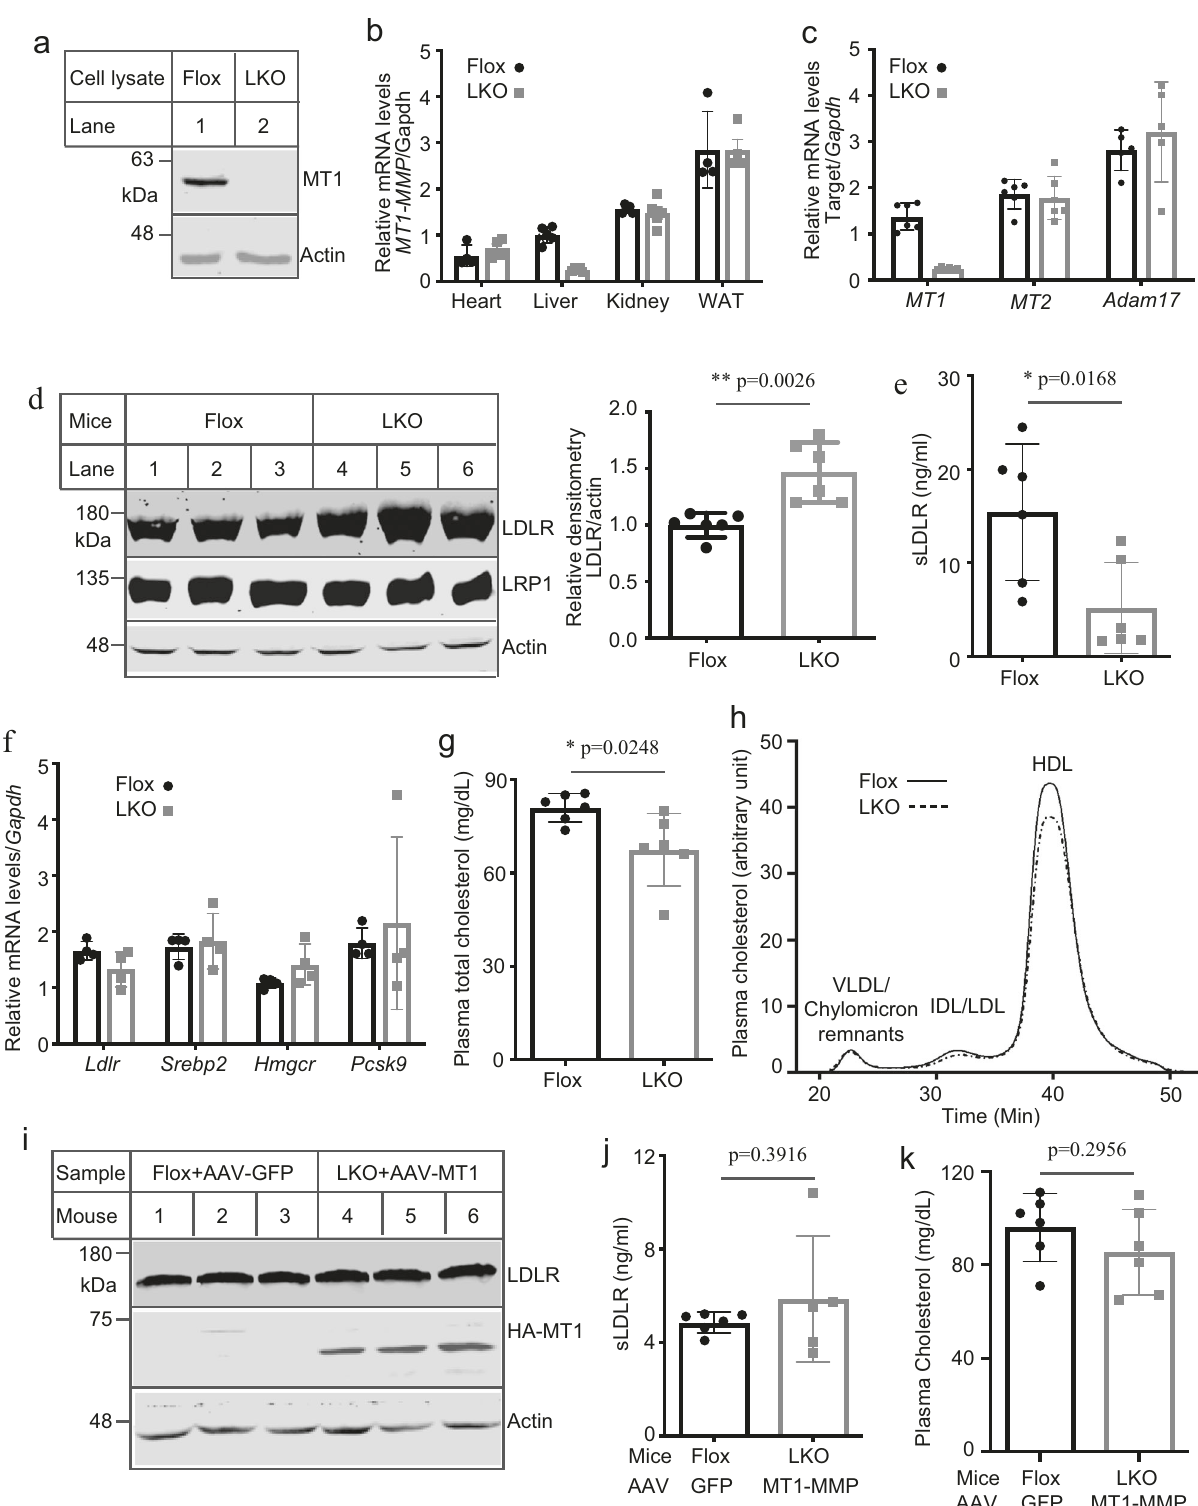
and group 3) the high plasma cholesterol levels (total cholesterol ≥ 6.1 mM or LDL cholesterol ≥ 4.1 mM, N = 21). The levels of sLDLR in the medium and high groups were signi fi cantly higher than that in the normal group, while there was no signi fi cant difference between the medium and high group (Fig. 6i). Given the critical role of PCSK9 in regulation of plasma LDL cholesterol and hepatic LDLR levels, we also measured circulating PCSK9 in